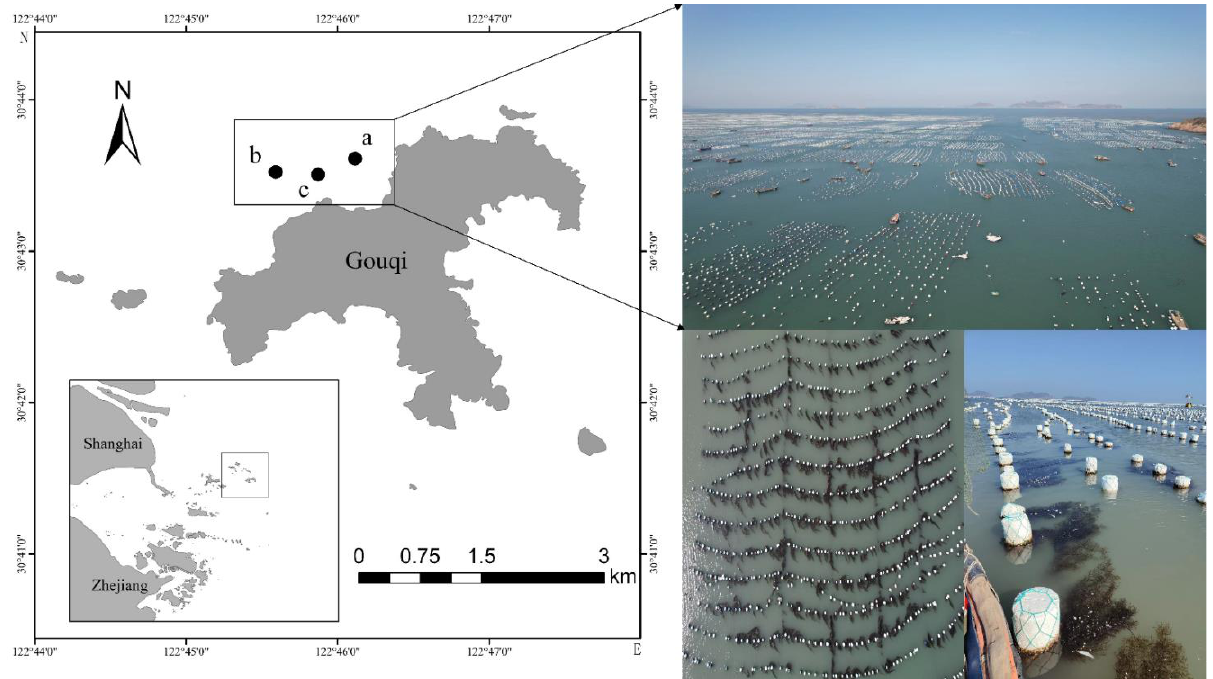
Figure 1. Map showing the stations randomly selected for the sampling of attached S. horneri in the mussel culture area of Gouqi Island.